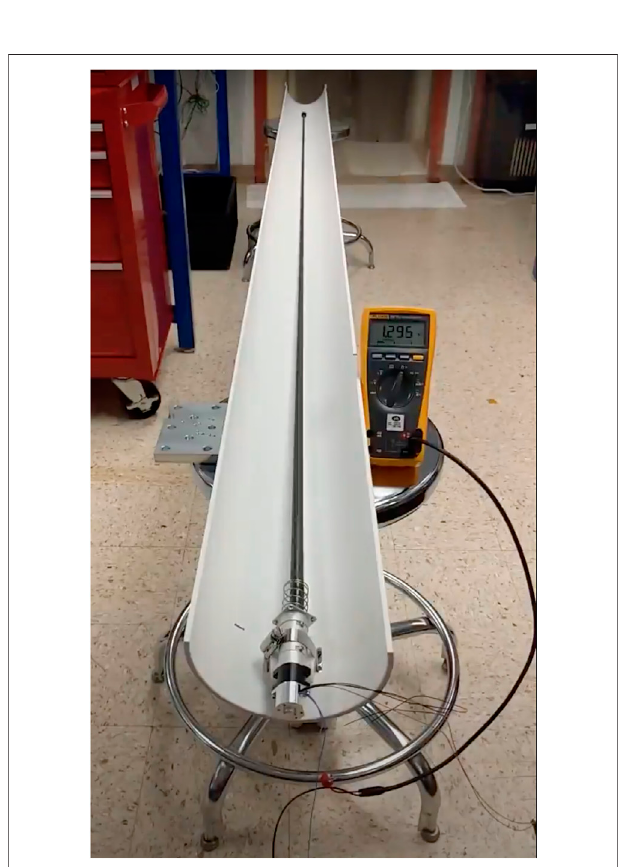
FIGURE 6 | A deployed CURIE stacer antenna undergoing ground